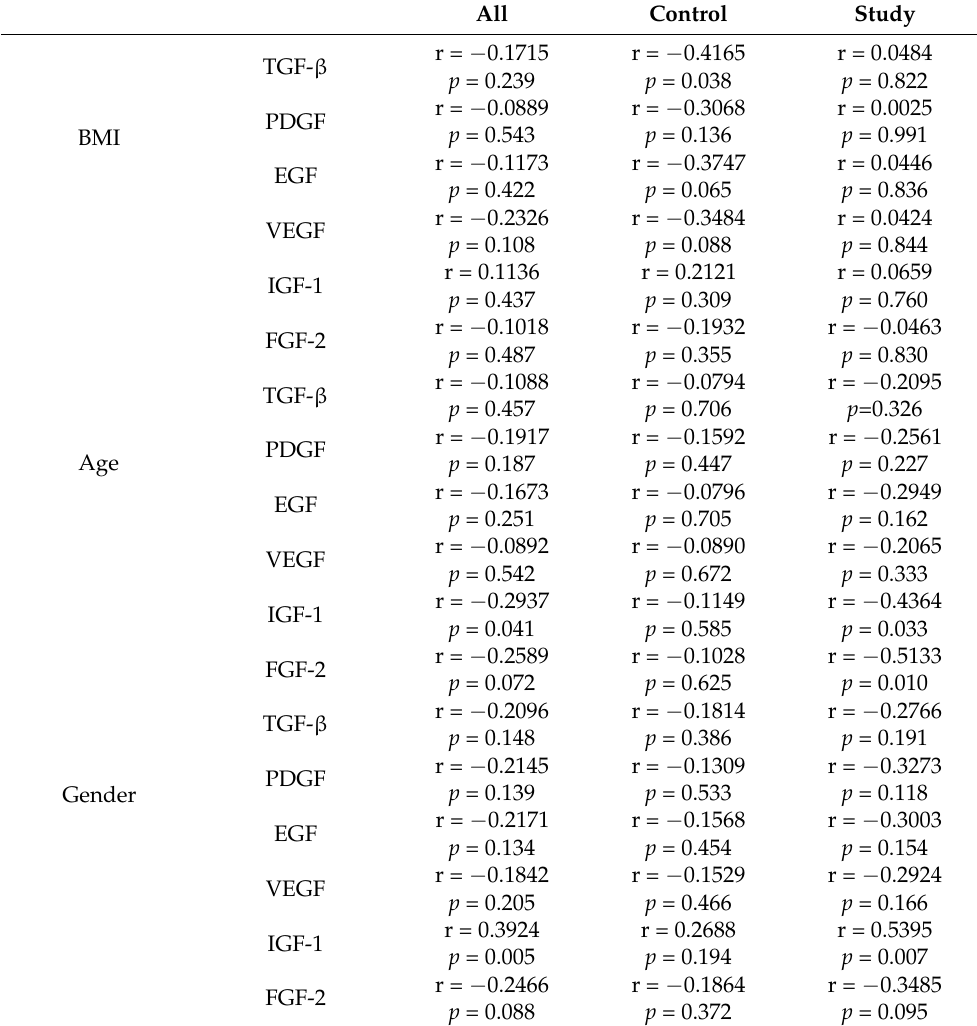
Table 4. Pearson correlation between markers and basic anthropometric